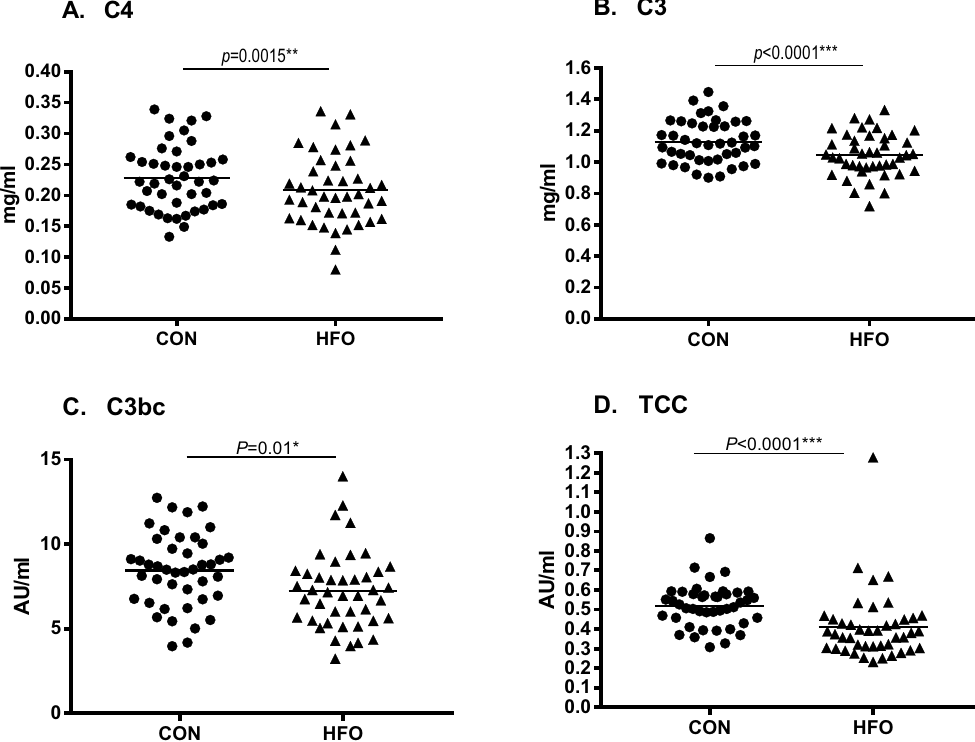
Figure 1. Circulating C4, C3, C3bc and TCC in response to overfeeding. Serum levels of C4 and C3 and plasma level of complement activation products C3bc and TCC after a control diet and after overfeeding in all subjects (n = 43). Data are reported as scatter-dot plots and medians. Paired two-tailed t-test p-values represent the difference in serum/plasma concentration before and after overfeeding. AU, arbitrary units; CON, control diet; HFO, high-fat